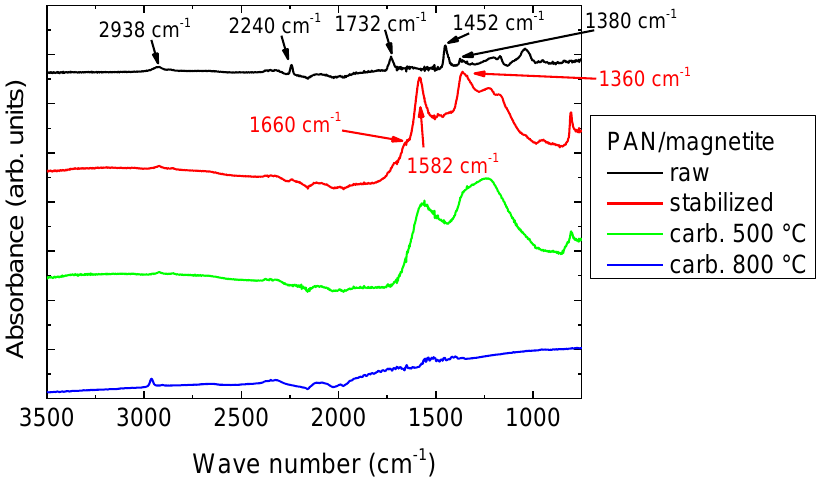
Figure 6. FTIR measurements of PAN/magnetite samples after electrospinning, stabilization, and carbonization at 500 and 800 °C. The lines are vertically offset for clarity.